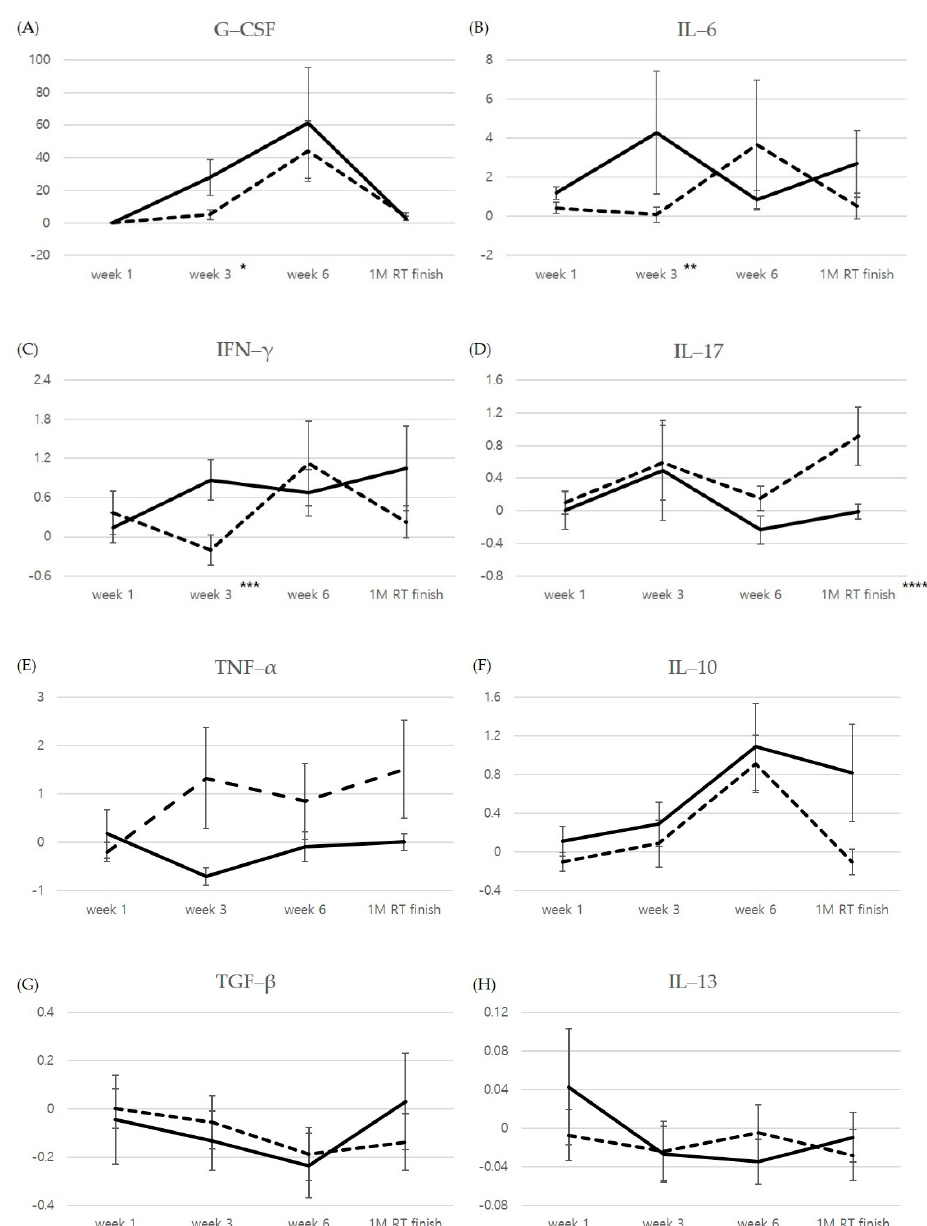
Figure 2. Relative changes in cytokine levels compared to pre-RT levels: ( A ) G-CSF; ( B ) IL-6; ( C ) INF- γ ; ( D ) IL-17; ( E ) TNF- α ; ( F ) IL-10; ( G ) TGF- β ; ( H ) IL-13 levels. Data are expressed as the mean ± SE. Gr ≥ 2 radiation pneumonitis, ‒ ‒ ‒ ‒ Gr 0–1 radiation pneumonitis. * p = 0.026, ** p = 0.050, *** p = 0.026, **** p = 0.045.